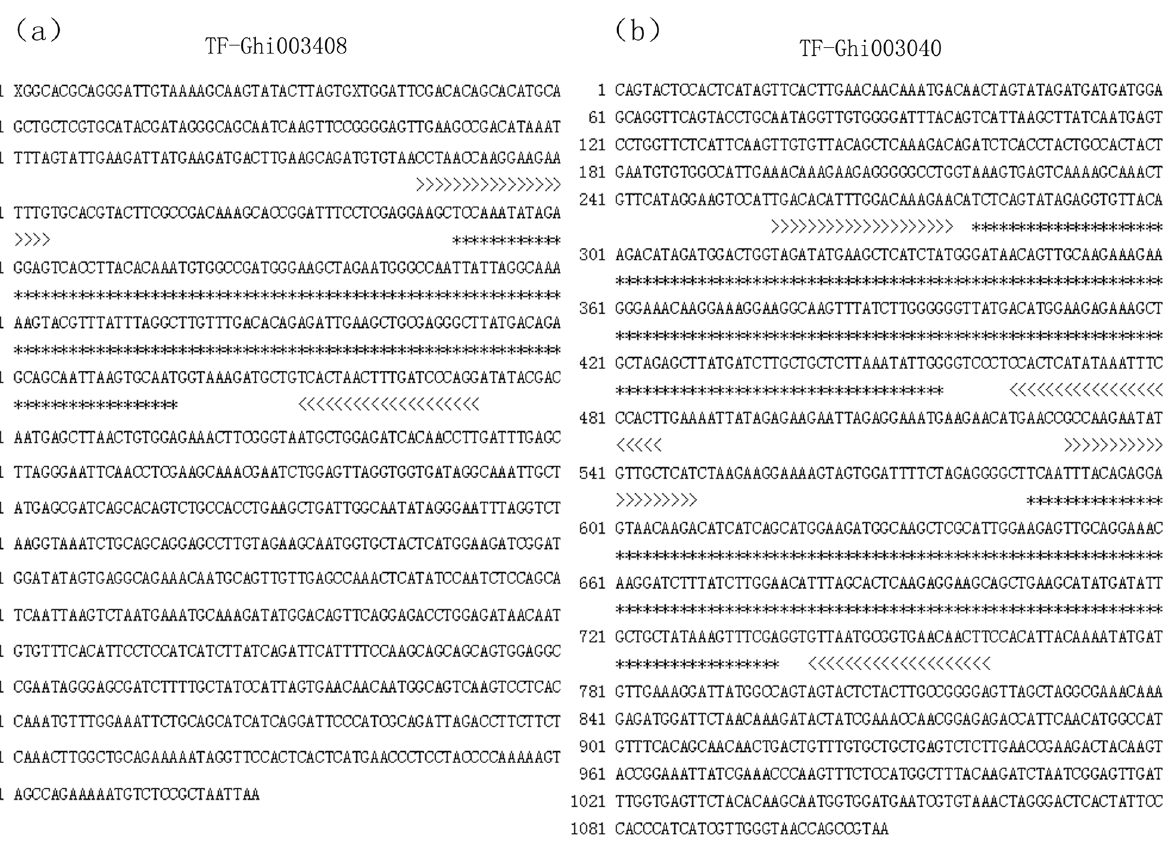
Fig 1. Primer design strategies for TFs. (a) TFs with one motif (GenBank acc No. Ghi003408); (b) TFs with two motifs (GenBank acc No. Ghi003040). * : Target sequence; >>>>> : Primer region.